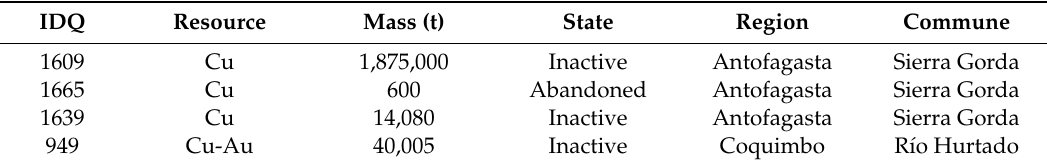
Table 6. Characteristics of the most critical tailings from a risk viewpoint, according to Dutch, Canadian, and Australian reference frameworks.